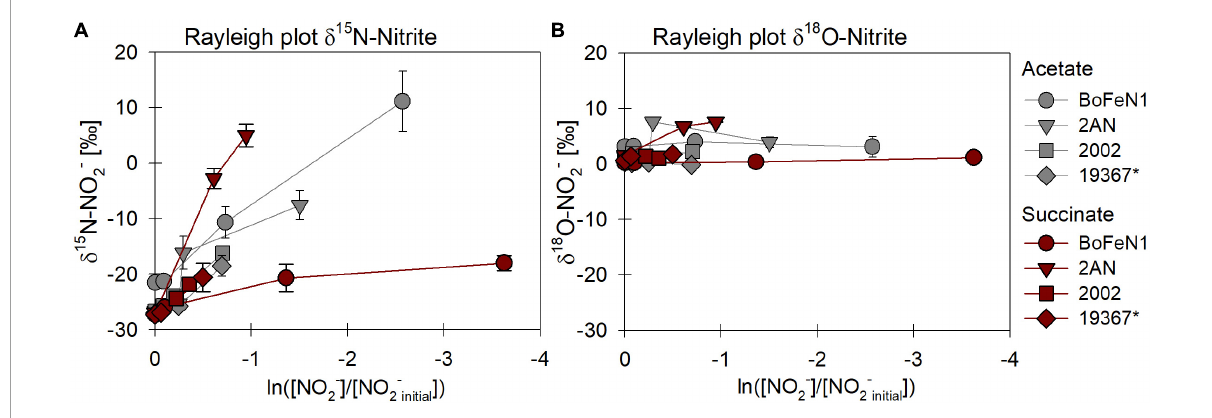
FIGURE8 Rayleigh plots of δ 15 N (A) and δ 18 O-NO 2 − (B) for different bacterial strains grown under heterotrophic conditions [acetate (gray), succinate (red)]. Error bars represent standard error calculated from biological replicates (see Table 4 ). * Marks the control denitrifier Paracoccus denitrificans strain ATCC